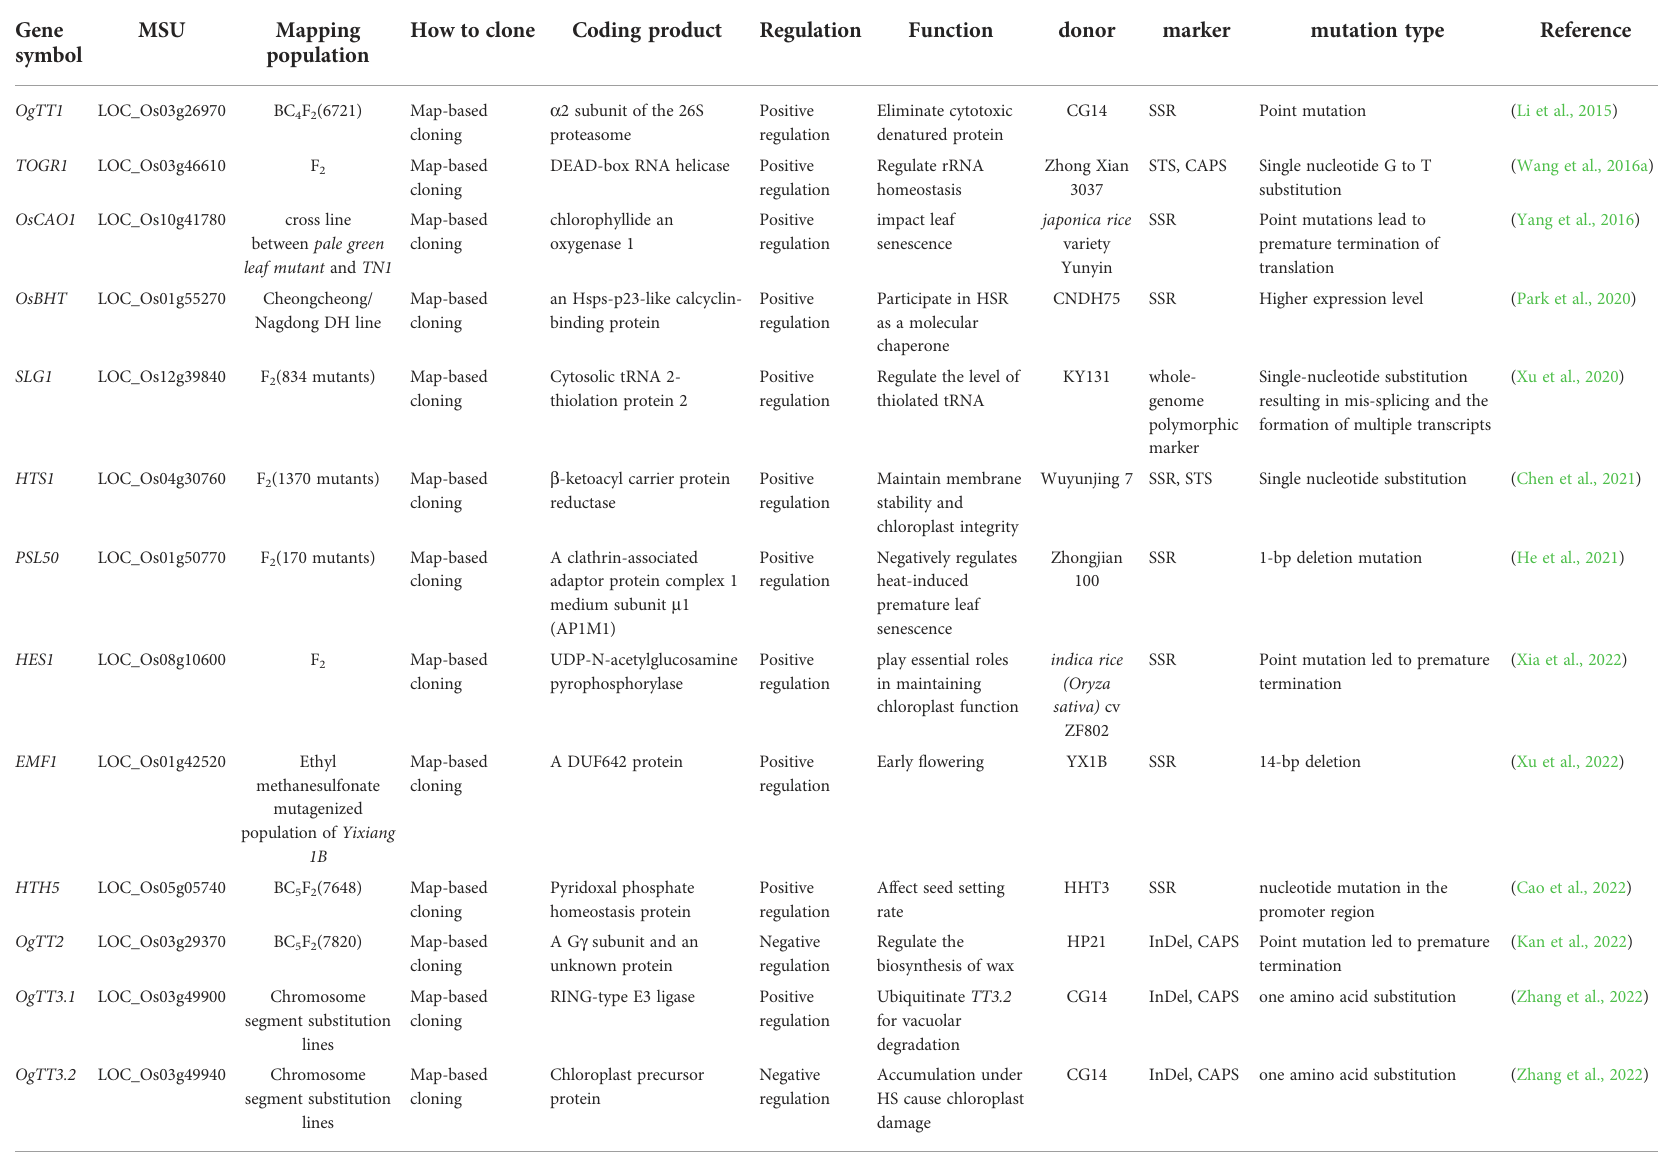
TABLE 1 The map-based cloned genes related to heat tolerance in